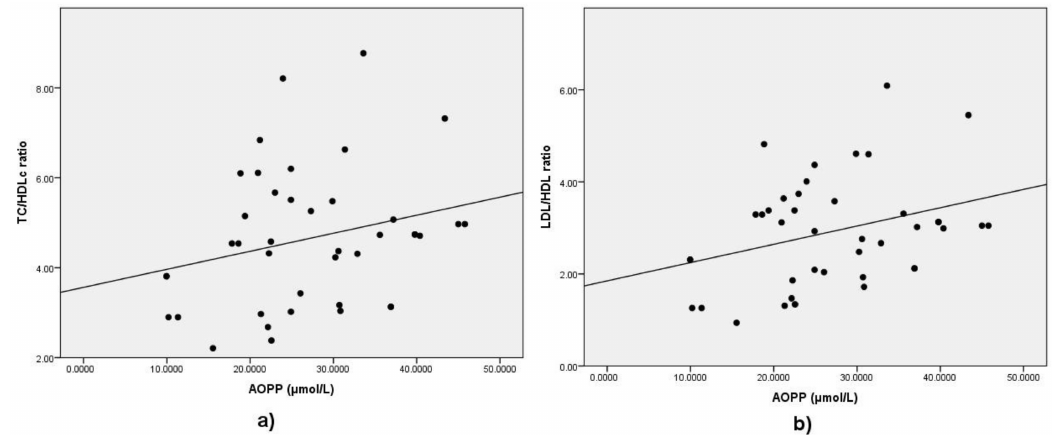
Figure 6. Correlation between AOPP and ( a ) TC/HDL-cholesterol ratio, and ( b ) LDL/HDL-cholesterol ratio. Legend: AOPP = advanced oxidation protein products; TC = total cholesterol; HDL = high-density lipoprotein; LDL = low-density